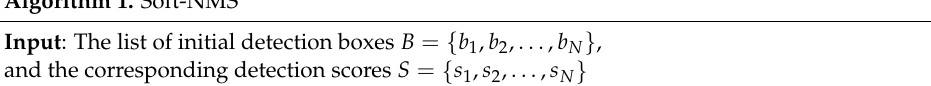
Figure 10. Number of anchors vs. the mean IoU. Algorithm 1.